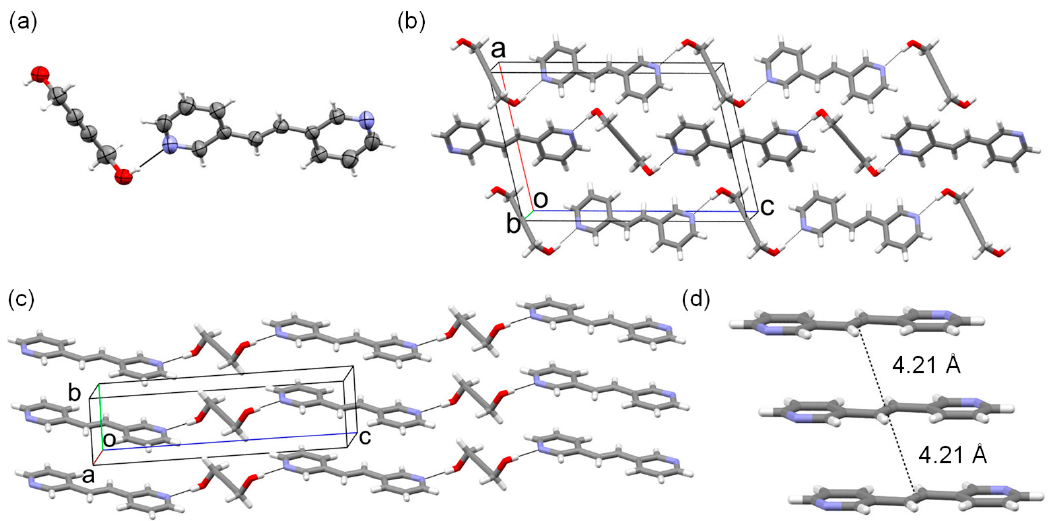
Figure 2. X-ray structure [( 1,4-bd )·( 3,3’-bpe )] n : ( a ) ORTEP representation; ( b ) 1D chains; ( c ) stacks of hydrogen-bonded chains; ( d ) stacked C = C bonds of 3,3’-bpe .